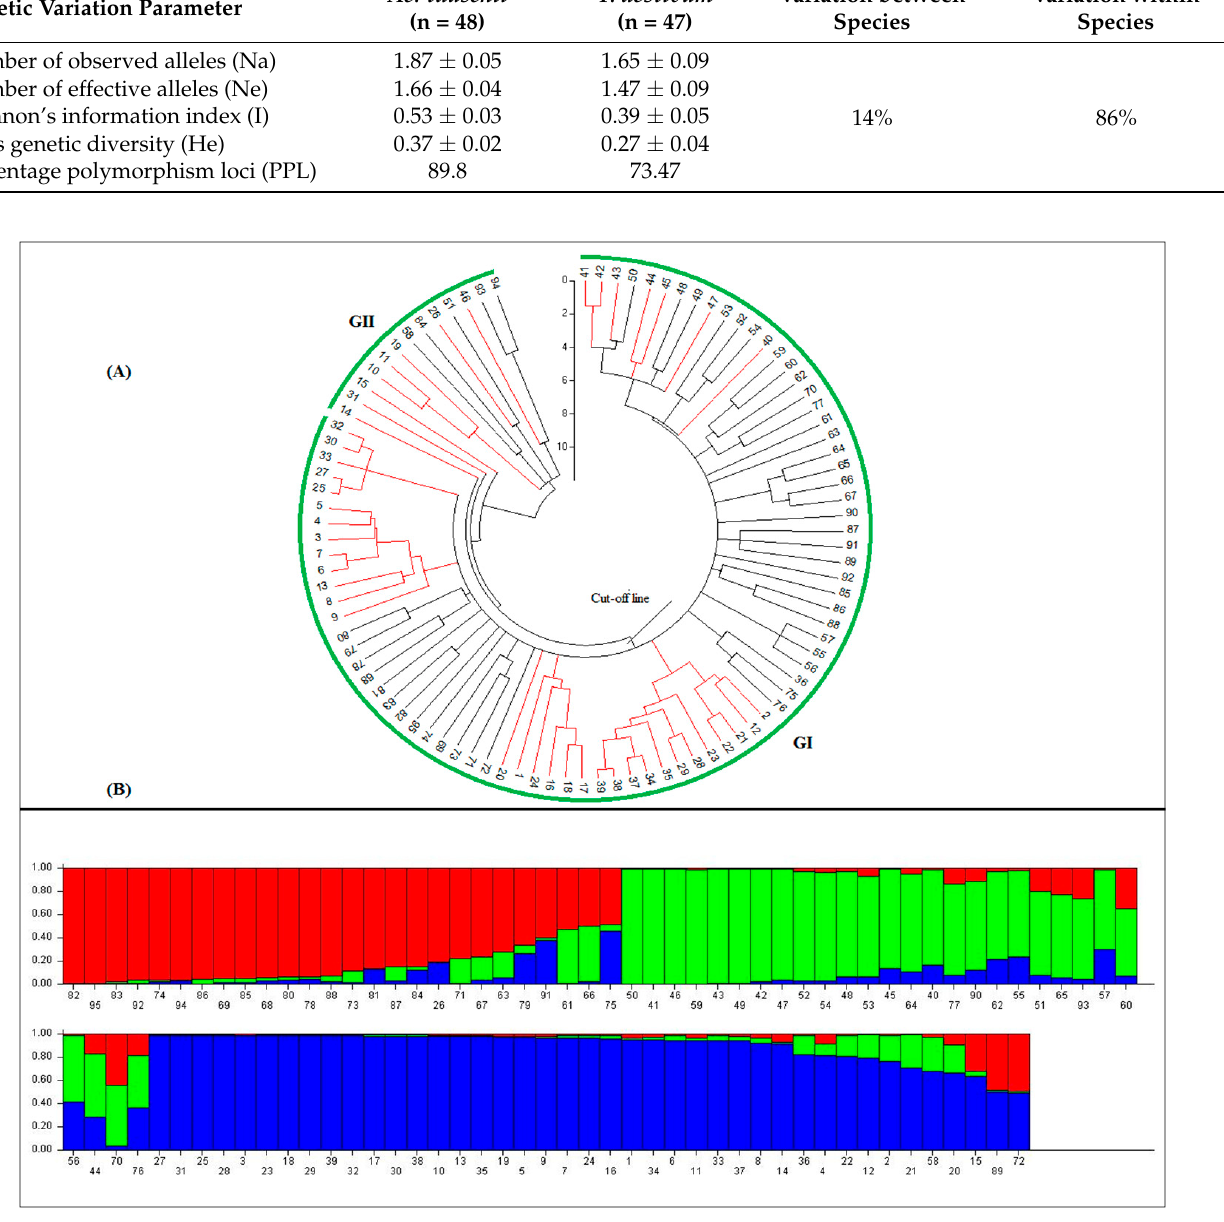
Figure 2. ( A ) The fan dendrogram generated using the neighbor-joining clustering method based on the 95 investigated samples. The red and black lines indicate T. aestivum and Ae. tauschii acces- sions, respectively. ( B ) Population structure of the 95 investigated individuals using 24 polymorphic SSR markers inferred by structure. The actual number of subpopulations (K = 3) was estimated ac- cording to Evanno’s test [24]. In both panels, numbers indicate the investigated accessions (Supple-